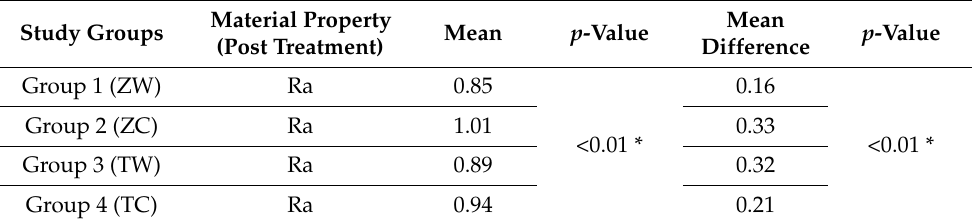
Table 11. Comparison of post-treatment surface roughness (Ra) among study groups. Study Groups